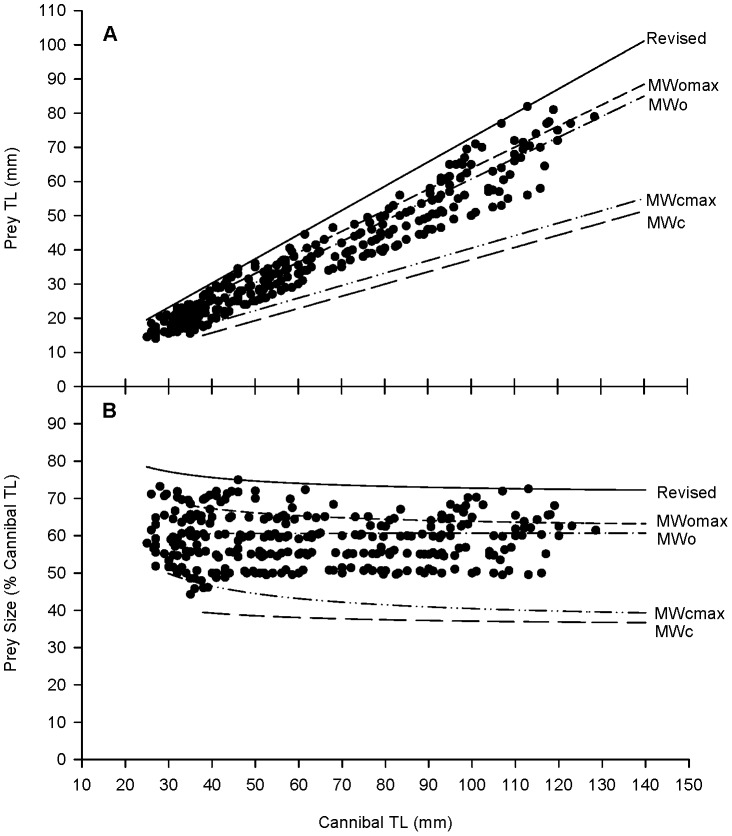
Maximum conspecific prey size for barramundi cannibals.Prey size in panel A is expressed as prey TL, mm, and in panel B expressed as % of cannibal TL. Regression lines include (1) the maximum size of prey ingested (“Revised” in filled circles on the top) and (2) model predictions on prey size based on closed mouth width (MWc), maximum closed mouth width (MWcmax), opened mouth width (MWo), and maximum opened mouth width (MWomax).